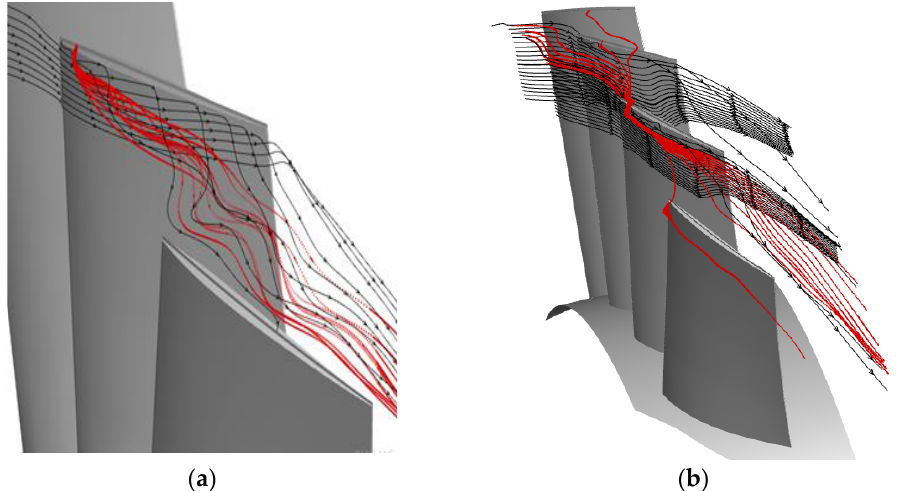
Figure 18. Blade-tip streamlines in in the U_A_122400Pa model. ( a ) First-stage rotor, R1, and ( b ) second-stage rotor, R2.